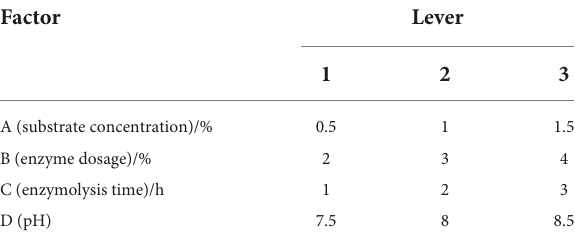
TABLE 1 Table of orthogonal experiment